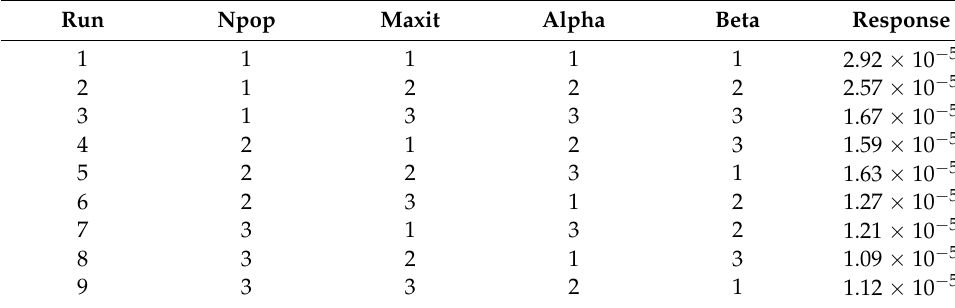
Table A9. The orthogonal array L9 and computational results for